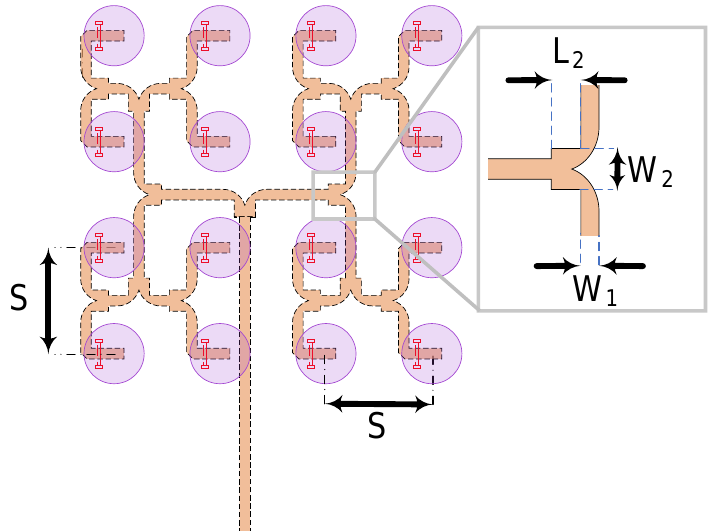
Figure 11. Feeding network schematic (ground plane hidden).